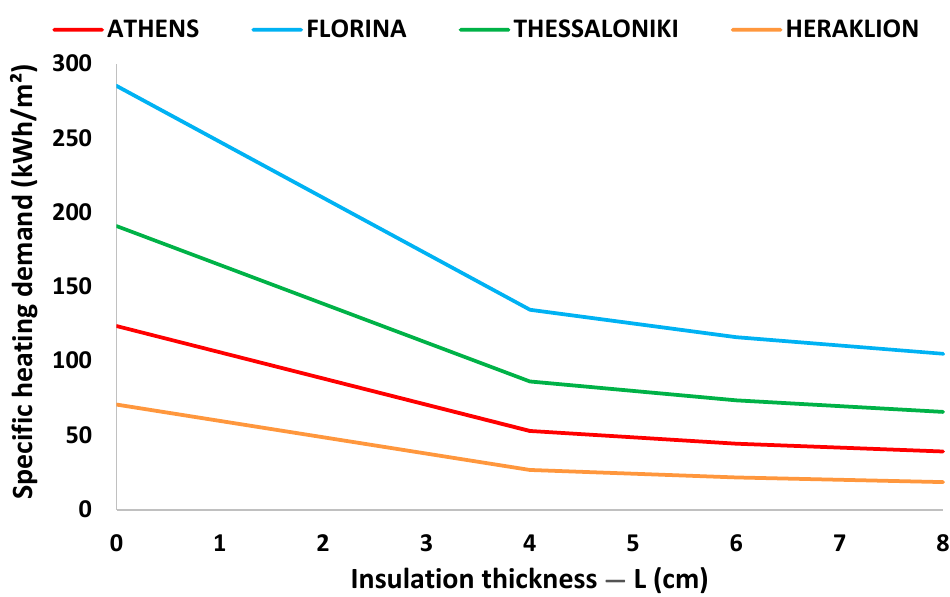
Figure 3. Specific heating demand for the examined cases.